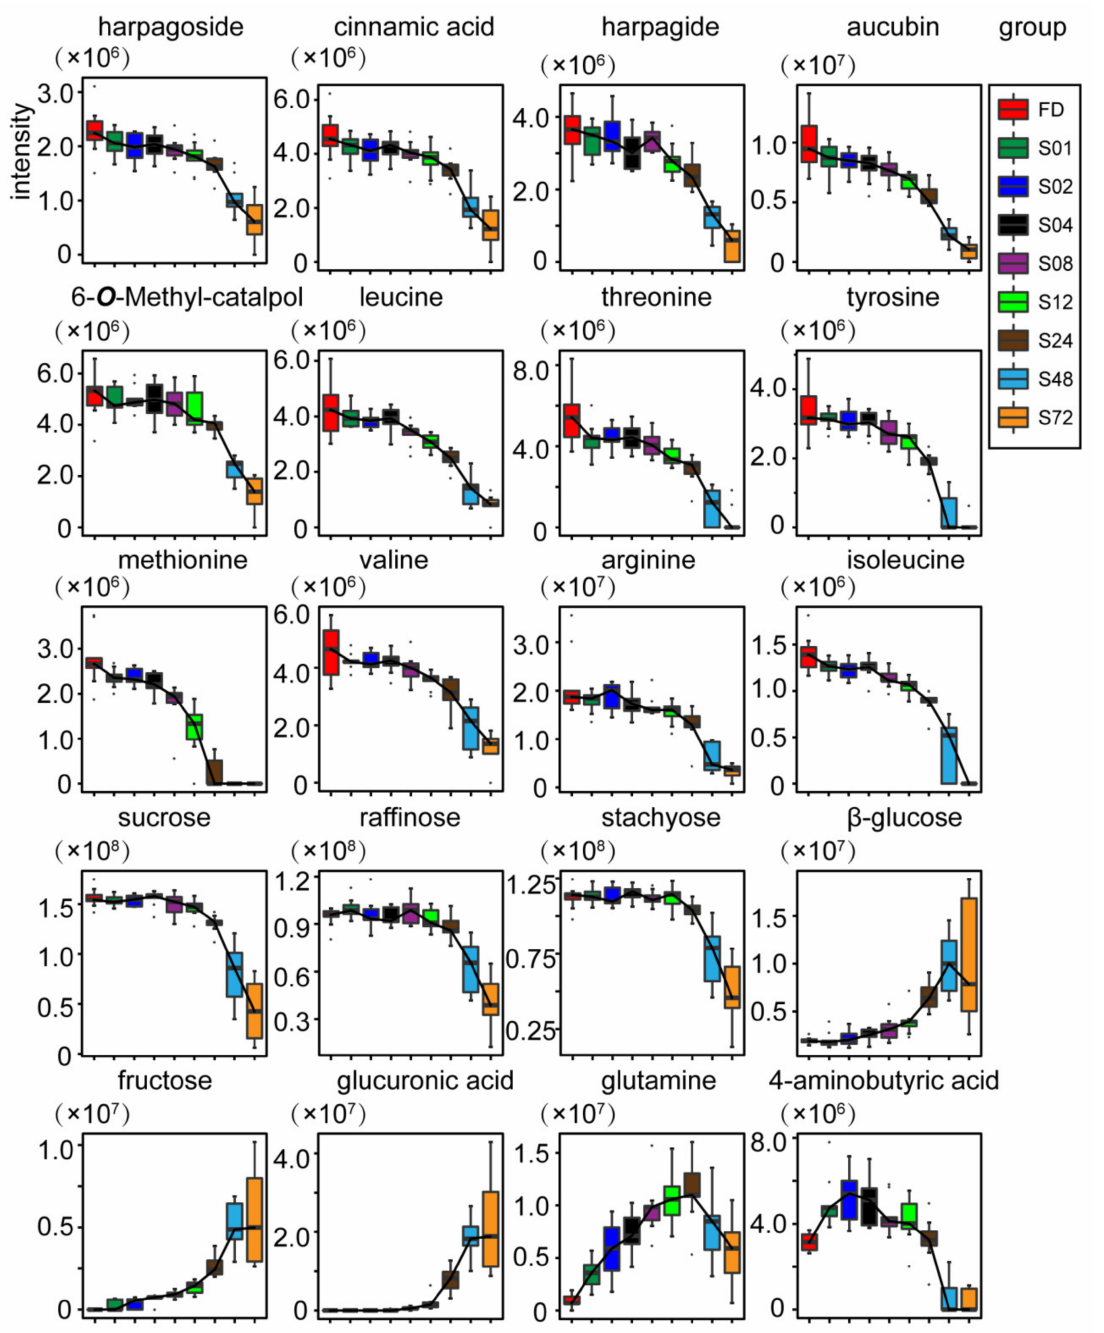
Figure 3. Boxplots of the relative intensities of 20 differential compounds at different steaming durations, 1 (S01, green), 2 (S02, blue), 4 (S04, black), 8 (S08, purple), 12 (S12, light green), 24 (S24, brown), 48 (S48, light blue), and 72 h (S72, yellow), compared with the vacuum freeze-dried (FD, red)